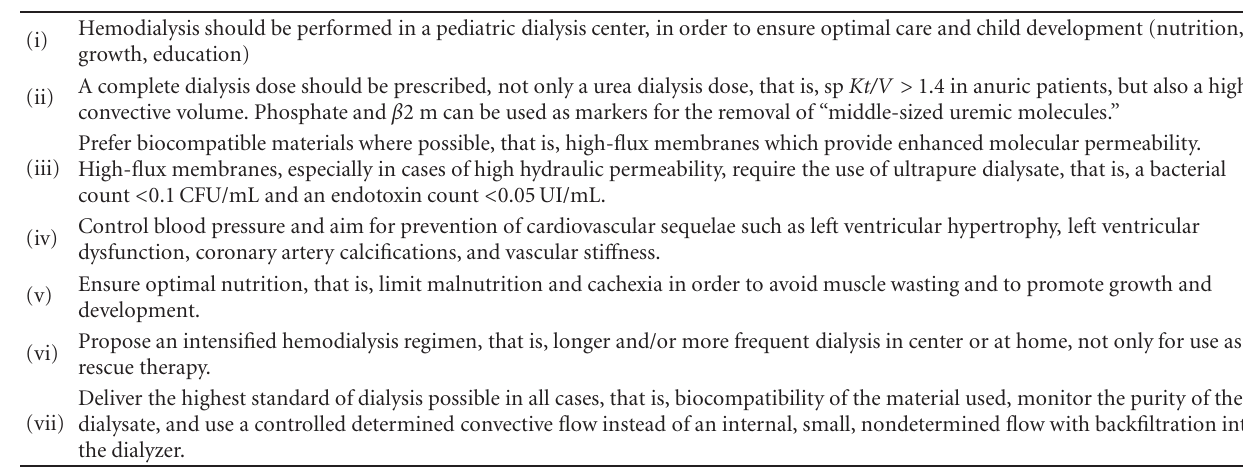
Table 1: Adequate hemodialysis prescription for children: more than a urea dialysis dose (adapted from [4, 5, 11, 19, 27]). Hemodialysis should be performed in a pediatric dialysis center, in order to ensure optimal care and child development (nutrition, (i) growth,